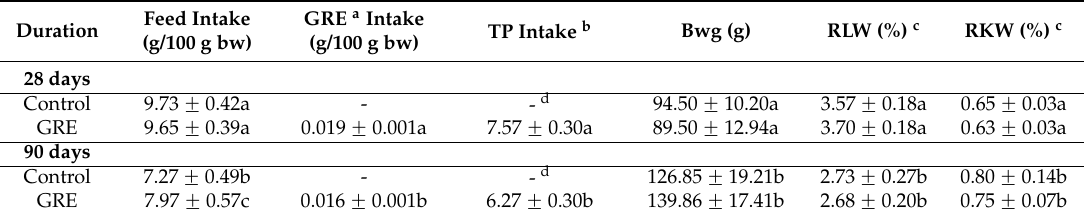
Table 1. Average feed, GRE and TP intake, as well as relative liver and kidney weights after dietary consumption of GRE a by male Fischer rats for 28 and 90 days. Values represent the mean ± SD of ten rats per group and means in a column followed by different letters differ significantly ( p < 0.05); a Feed mixture contained 2.0 g GRE extract/kg; b mg Gallic acid equivalents/100 g bw/day; c % bw, d TP content of control diet not assessed. Abbreviations: bw, body weight; bwg, bodyweight gain; GRE, green rooibos extract; RKW, relative kidney weight; RLW, relative liver weight; TP, total polyphenol.